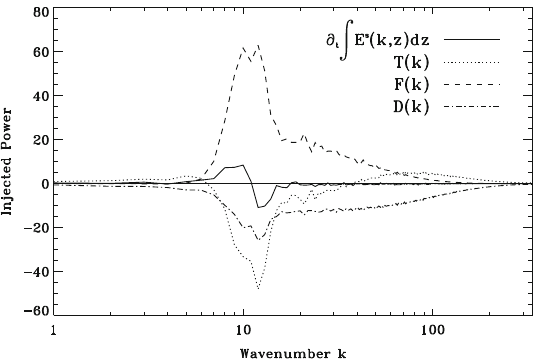
Fig.14 Spectral-space energy budgets as a function of integer horizontal wavenumber k in the large-aspect ratio simulations of turbulent convection described in Figs. 12 (left) and 13. Here, F ( k ) is the buoyancy forcing term, T ( k ) is the nonlinear transfer (cascade) term, and D ( k ) is the dissipation term. The dominant balanceinthepeakinjectionrangeisbetweenthepositivebuoyancyforcingtermandthenegativenonlinear transfer term, indicating that the large-scale dissipative structures seen in Fig. 12 (left) are powered by buoyancy. This injected power is dissipated by turbulent viscous dissipation mediated through spectral space by smaller-scale turbulent convective motions. Image reprpoduced with permission from Rincon et al. (2005), copyright by